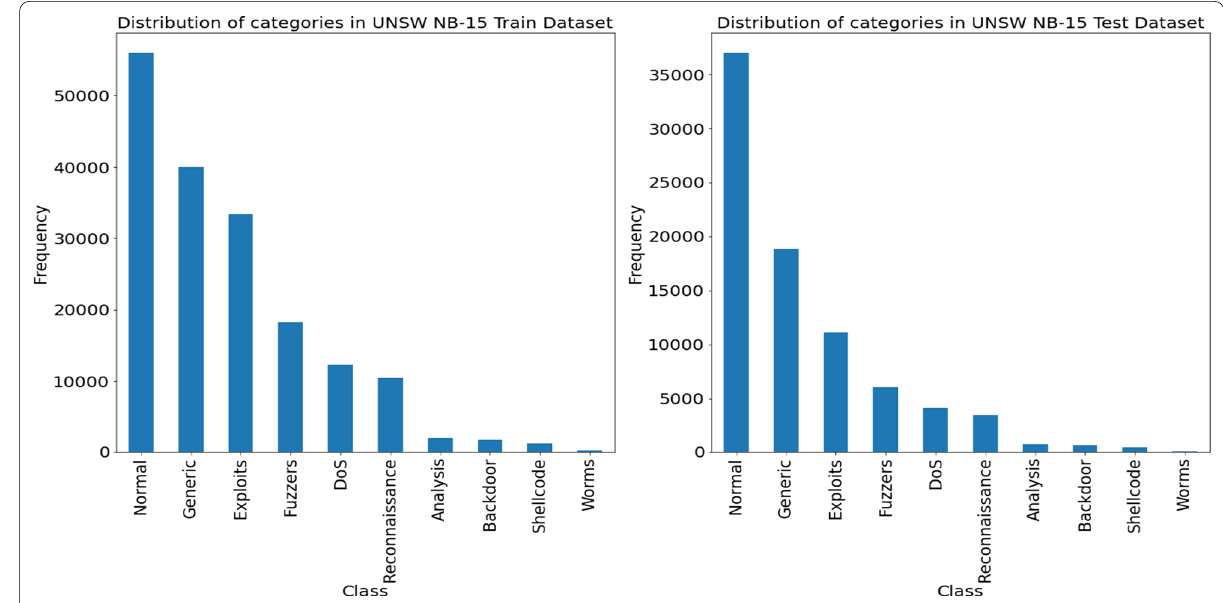
Fig. 4 Distribution of categories in UNSW-NB 15 Train and Test